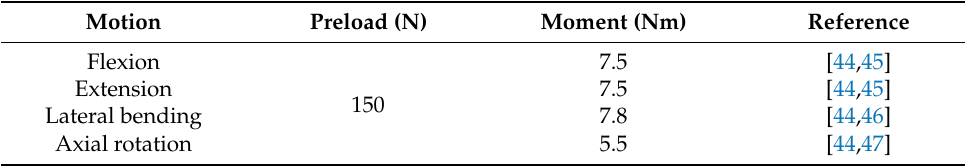
Table 3. Load for the simulation of each motion.